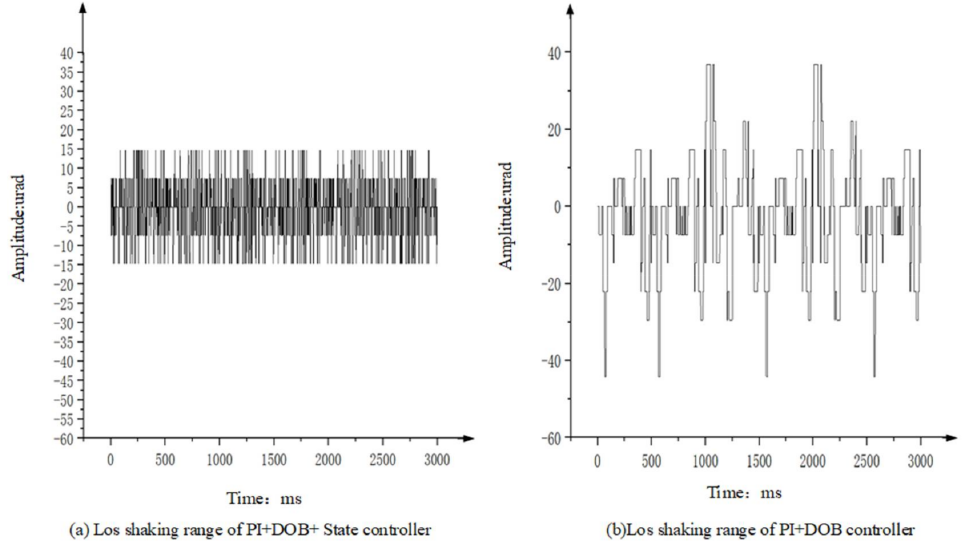
Figure 18. The shaking range of the Los of the